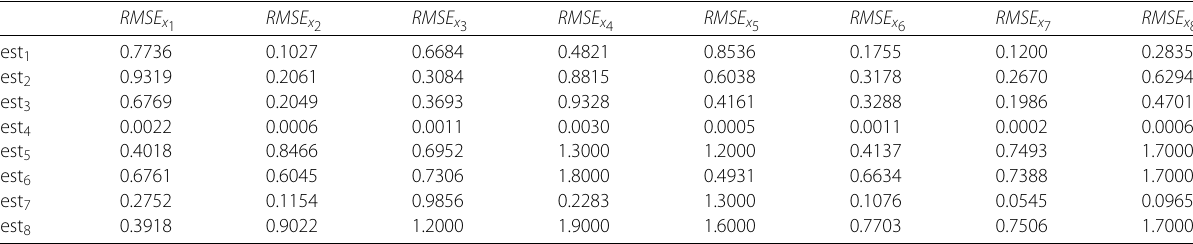
Table 1 Tracking RMSE × 10 –3 for the robotic tower crane in the disturbance-free case